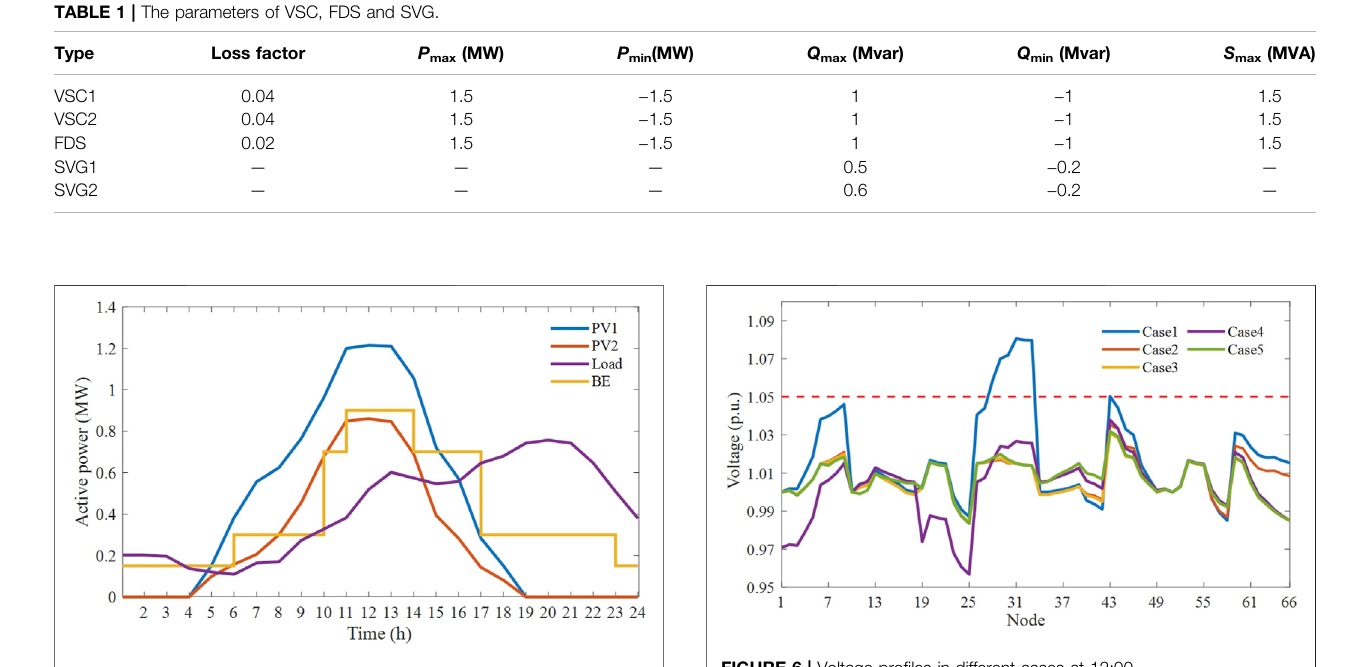
FIGURE 4 | Pro fi les of PV1, PV2, BE and loads.